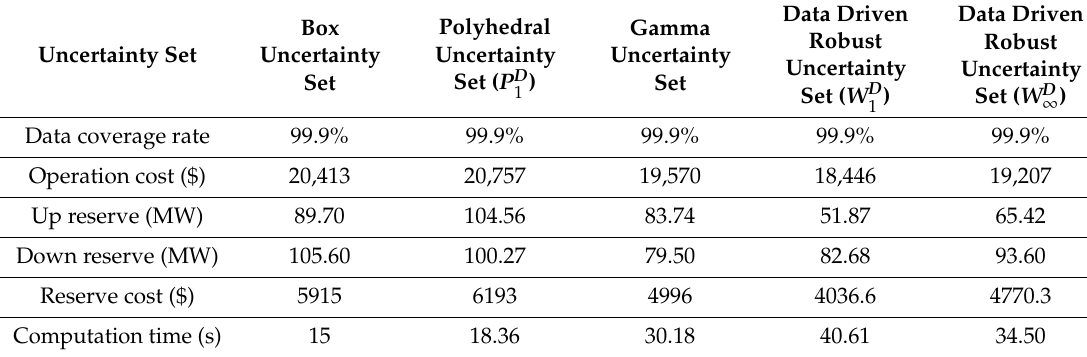
Table 3. Comparison of other robust optimization methods.